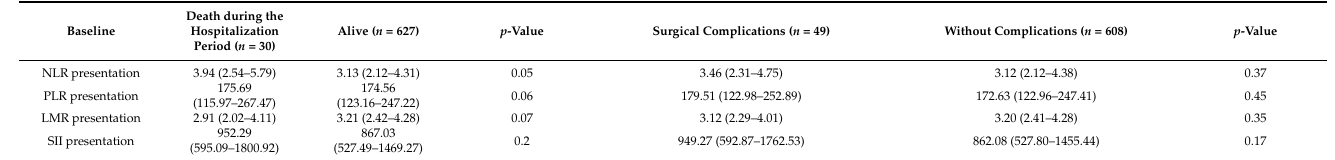
Table 6. The association of inflammatory ratios at presentation with post-operative complications (death during the hospitalization period and surgical